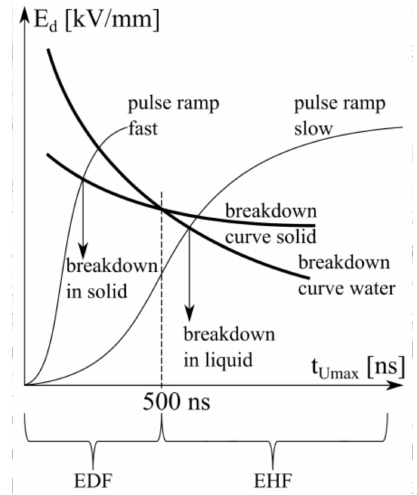
Figure 1. Electrodynamic and electrohydraulic breakdown regimes according to [15]. Correlation between dielectric strength E d and pulse rise time t Umax .